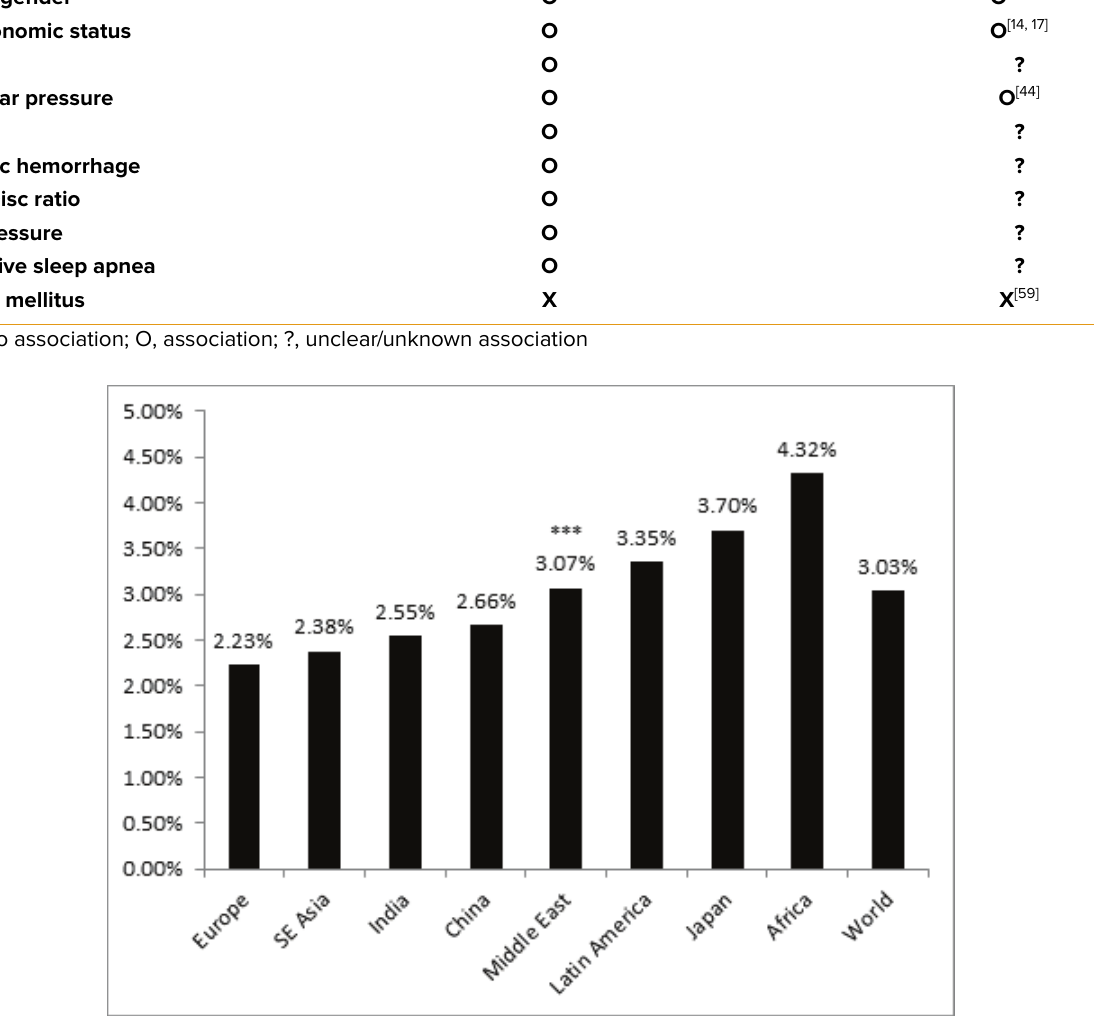
Figure 2. Graphical representation of worldwide primary open-angle glaucoma and angle closure glaucoma prevalence